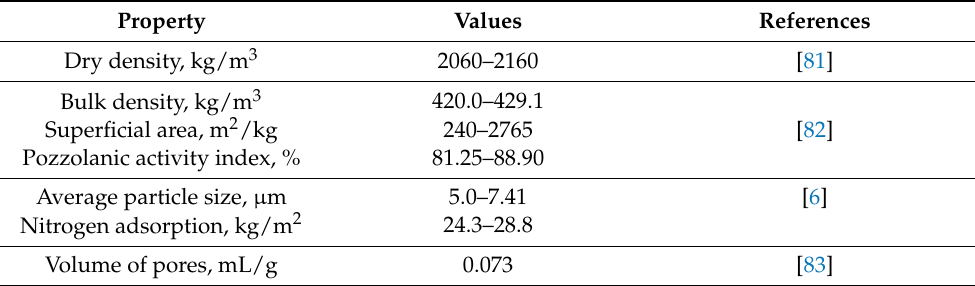
Table 5. Physical properties of